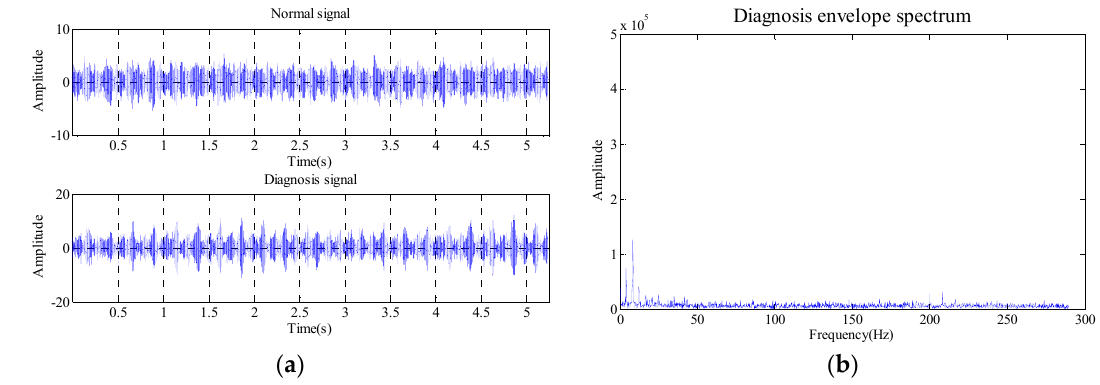
Figure 2. Waveform of time domain and envelope spectrum. ( a ) Time domain waveform; ( b ) Envelope spectrum waveform. Table 1. Singular value of trajectory matrix.